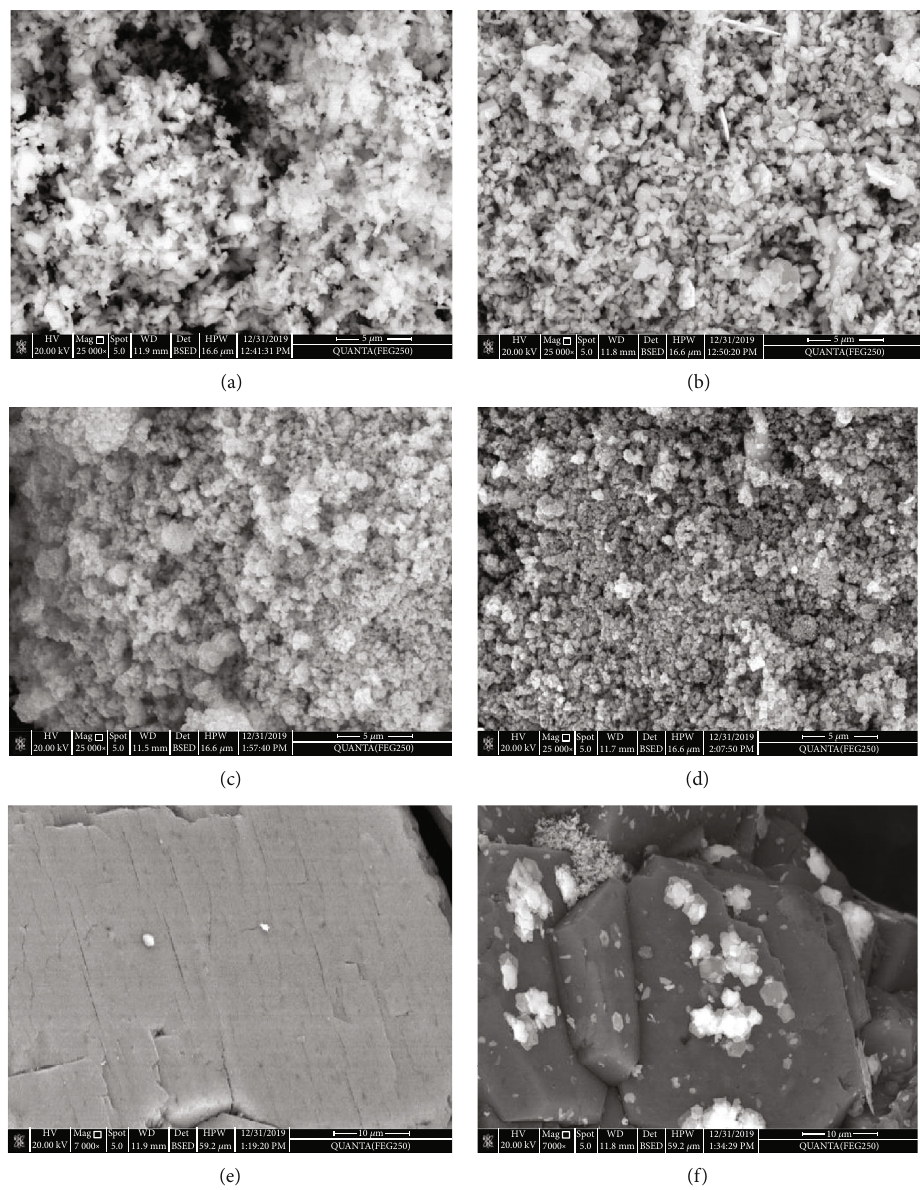
Figure 8: SEM micrograph: (a) unloaded ZnO at 25000x magni fi cation, (b) loaded ZnO at 25000x magni fi cation, (c) unloaded TiO 25000x magni fi cation, (d) loaded TiO 7000x magni fi